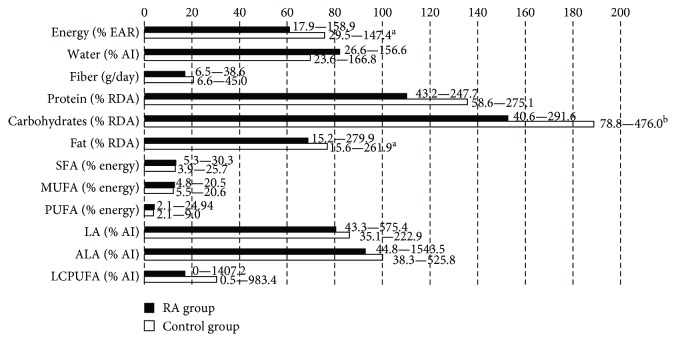
Macronutrient intake and dietary fat components in RA and control groups (% of recommendations)—median and range. SFA: saturated fatty acids; MUFA: monounsaturated fatty acids; PUFA: polyunsaturated fatty acids: LA: linoleic acid; ALA: α-linolenic acid; LCPUFA: long chain polyunsaturated fatty acids; EAR: estimated average requirement; AI: adequate intake; RDA: recommended dietary allowances. Statistically significant differences (p value): a<0.005, b<0.0001.